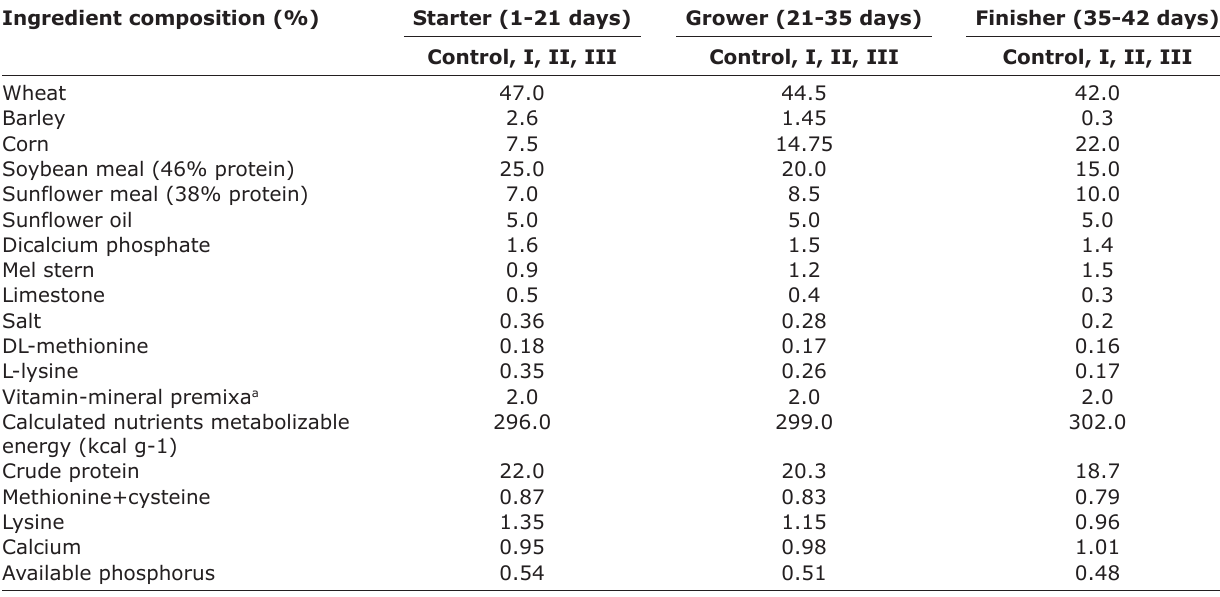
Table-1: Dietary ingredients (natural substance) and chemical composition (dry matter) of basal diets. Ingredient composition (%)